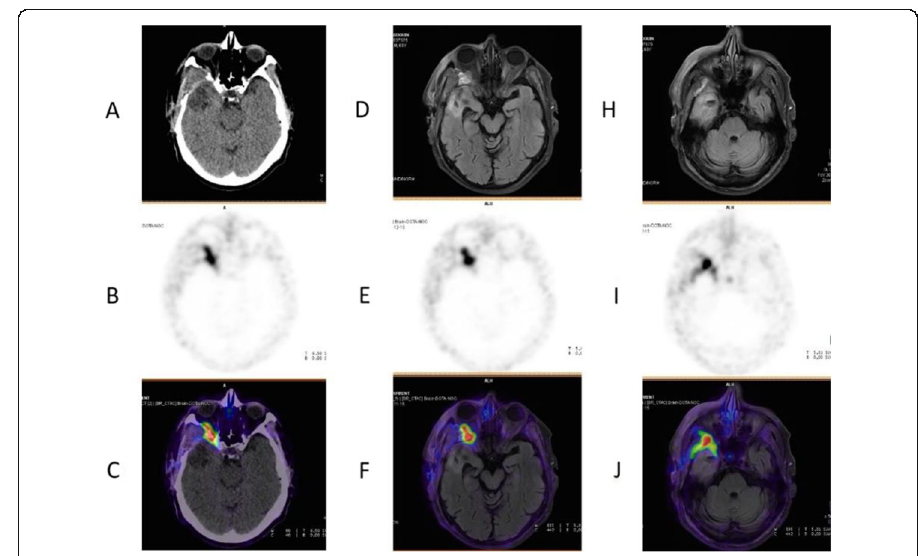
Fig. 64 68 Ga-DOTA peptide, meningioma. Clinical history : 70 y.o. man with meningioma of the skull basis. PET/CT findings : 68 Ga-DOTATATE shows highly increased uptake in the right sphenoidal bone area with an extension to the orbital cavity, corresponding to the meningioma ( a CT; d , h MRI; d , e , i PET; c fused PET/ CT; f , j fused PET and MRI)